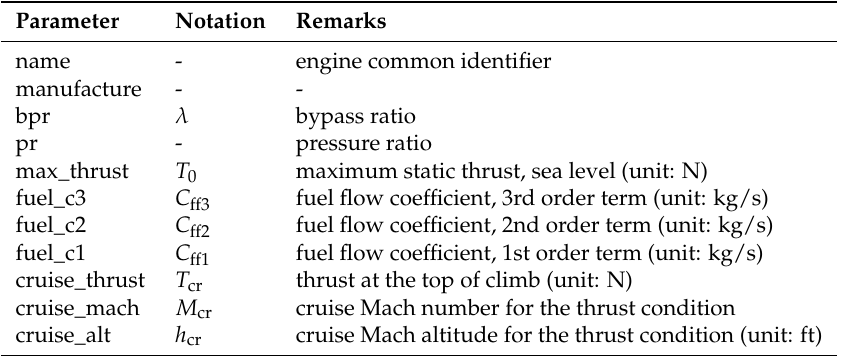
Table 1. Engine performance